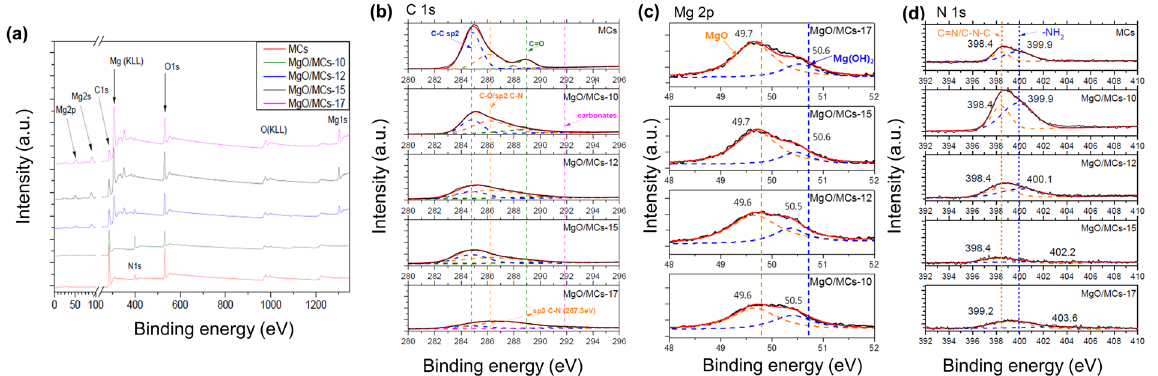
Figure 4. ( a ) Survey scan XPS spectra of the prepared MgO/MCs samples, high-resolution ( b ) C1s and ( c ) N1s XPS spectra of MgO/MCs samples with deconvoluted peaks.